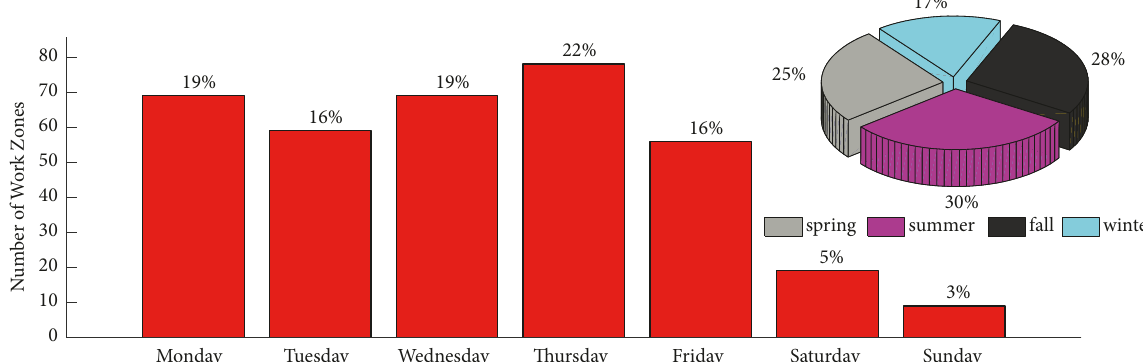
Figure 6: Most collisions took place on weekdays and during summer and fall, when high maintenance activity was observed.